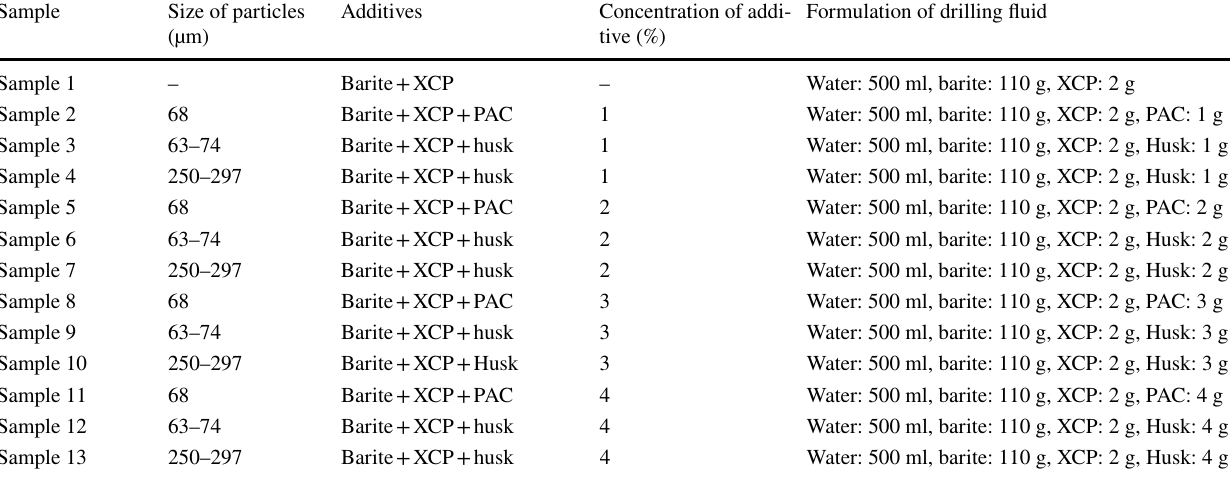
Table 1 Drilling fluid formulation with proposed additive obtained from groundnut husk and PAC from 1% to 4% by weight Sample Size of particles Additives Concentration of addi- Formulation of drilling (µm) tive (%)